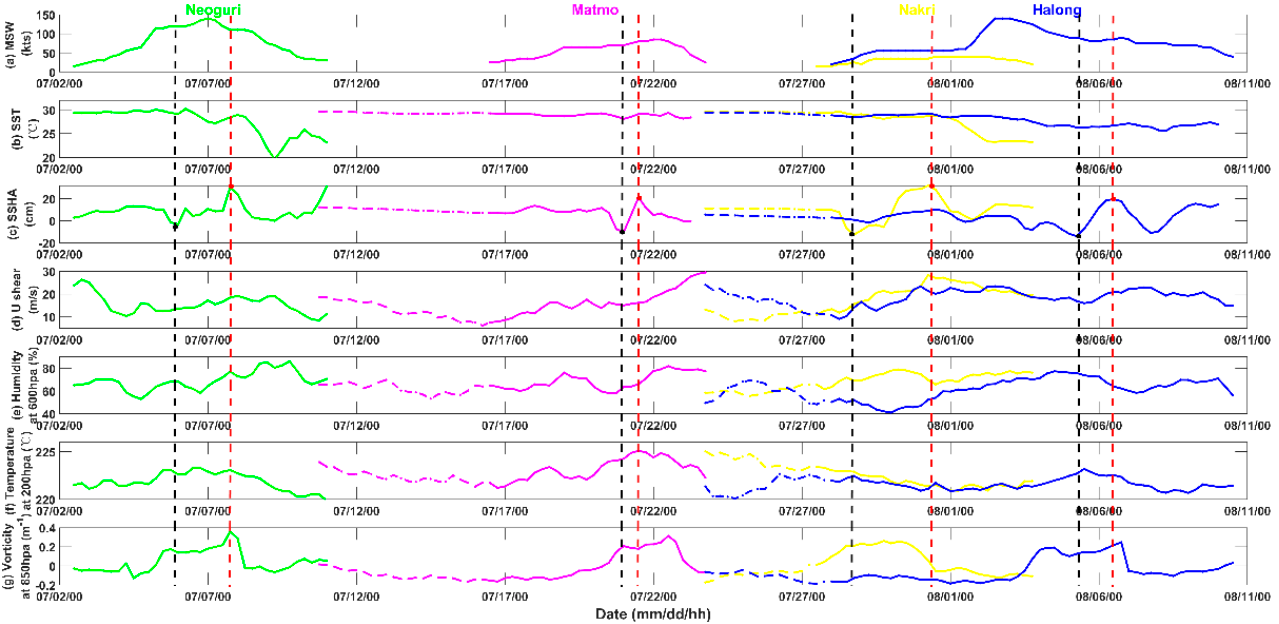
Figure 11. The evolutions of the MSW of sequential typhoons ( a ), the average inner-core SST ( b ), SSHA ( c ) within the radius of 200 km from the center of the typhoon, and the average vertical wind shear ( d ), relative humidity at 600 hPa ( e ), tropopause temperature at 200 hPa ( f ) within the radius from 200 to 800 km, and the average vorticity within the radius of 800 km ( g ) during four sequential typhoons.